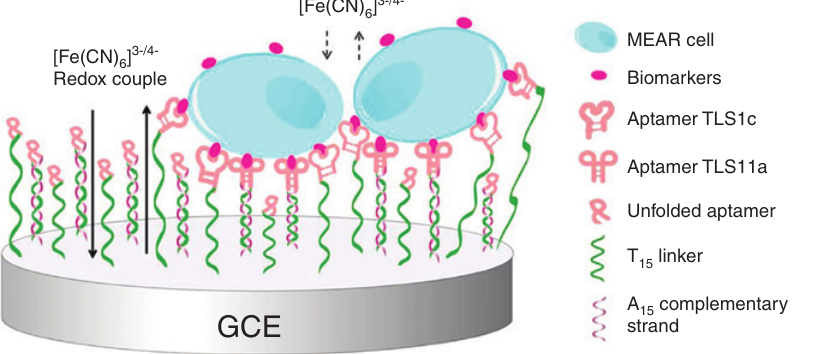
Figure 5: Scheme of the dual-aptamer modified electrode interface for specific and sensitive detection of MEAR tumor cells. Reprinted with permission from (Qu et al. 2014). Copyright (2014) American Chemical